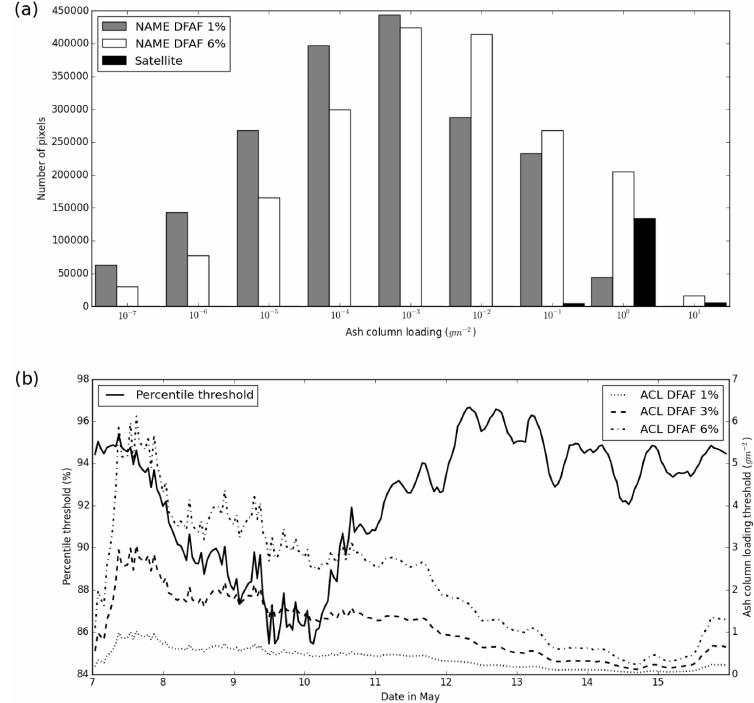
Figure 3. (a) Number of pixels as a function of column loading for 7–16 May 2010 for both NAME (distal fine ash fraction (DFAF) of 6% (white) and DFAF of 1% (grey)) and satellite observations (black). (b) Time evolution of the percentile threshold (solid line) and minimum ash column loading calculated by applying the pixel matching technique (DFAF 1% (dotted line), DFAF 3% (dashed line), DFAF 6% (dot-dash